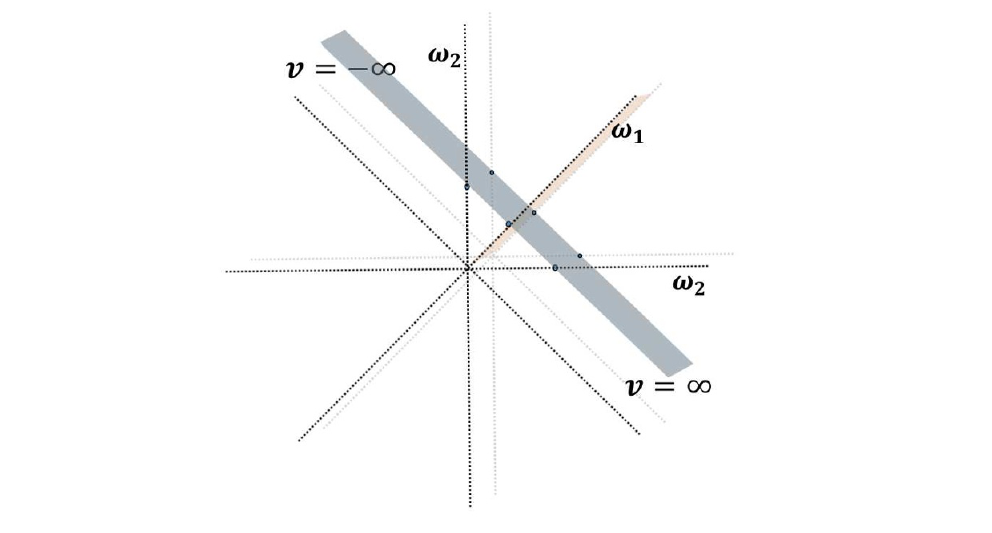
Figure 6 . Illustration of the upper w -half plane used by Caron-Huot inside the domain of Calogero- Sutherland